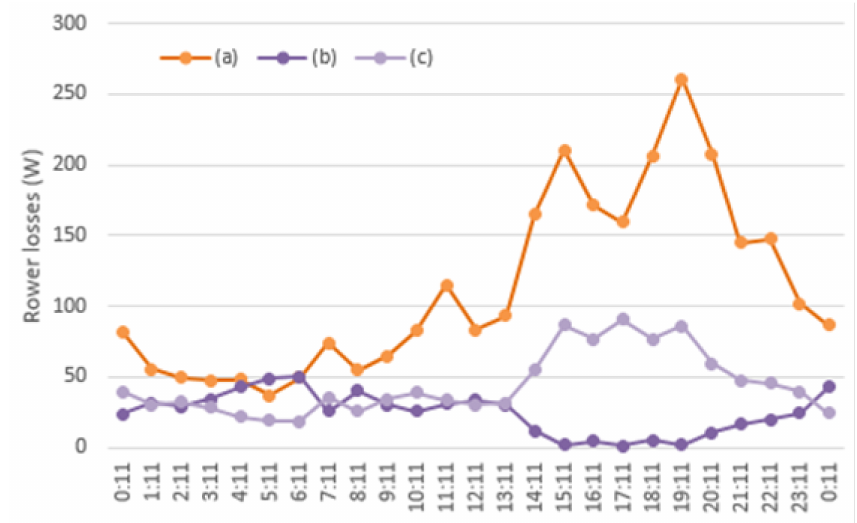
Figure 5. Transformer power losses in 24 h of a weekday due to: ( a ) active currents ( P ca ); ( b ) reactive currents with capacitors ( P (cid:48) cr ); and ( c ) reactive currents without capacitors ( P cr ).